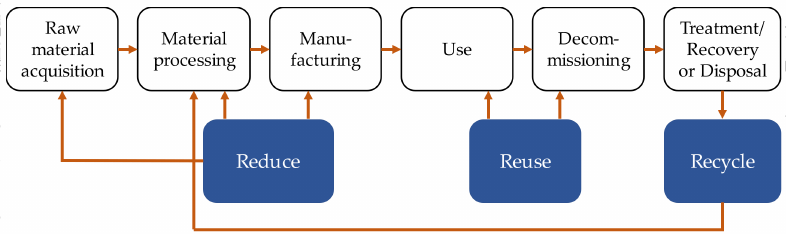
Figure 8. Process flow diagram of the life cycle stages for low carbon energy technology and resulting opportunities for reducing, reusing, or recycling (after [63]).